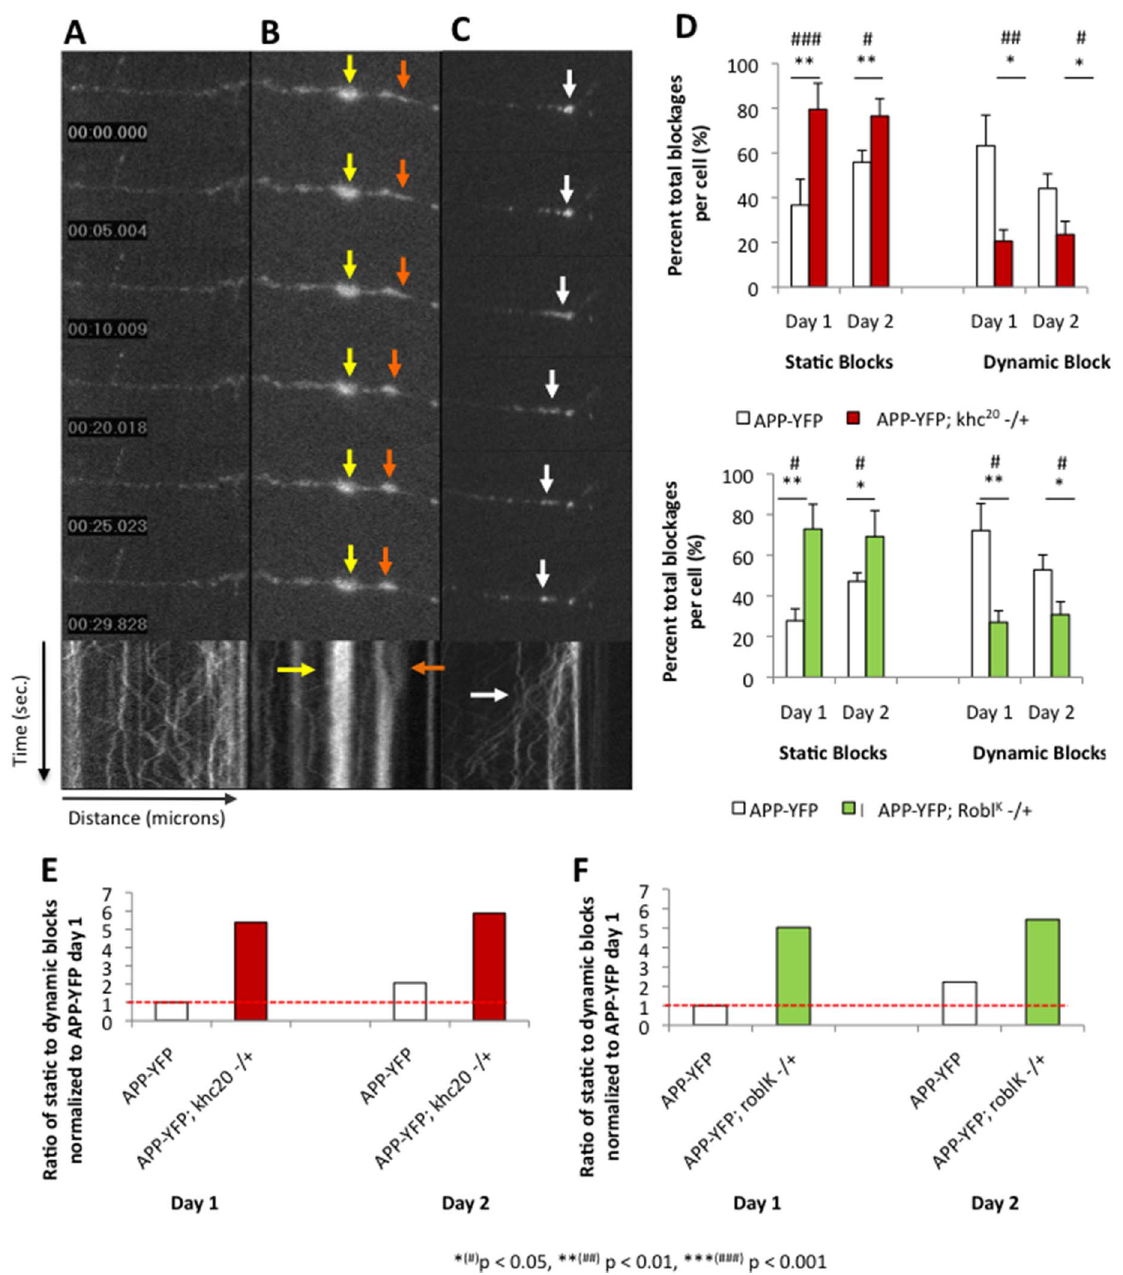
Figure 6. Two types of vesicle blockages are observed, static non-moving blocks that do not resolve over time and dynamic, clusters of vesicles that resolved over time. ( A ) In control neurites robust APP-YFP motility is observed with no vesicle blockages. A representative movie montage is shown with its kymograph. X axis=time (seconds), Y axis= distance (microns). ( B ) A representative axonal neurite shows a static non-moving APP block (yellow arrows) that do not resolve temporally (arrow in kymograph). In the same axonal neurite a static block being formed can be observed (orange arrows). ( C ) A representative axonal neurite shows a dynamic block that resolves over time (white arrow). Note that in the kymograph the block can be observed resolving over time and single vesicle tracks are seen over time (white arrow). Bar=10 microns ( D ) Quantitative analysis of the percent total blockages per cell is depicted from day 1 to day 2 for static and dynamic blocks. Note that 50% reduction of kinesin-1 or dynein significantly increases the percent of static, non-moving blocks (kinesin-1 p day1 =0.015; dynein p day1 =0.010 and p day2 =0.022), while the number of dynamic, motile blocks decreases (kinesin-1 p day1 =0.005 p day2 =0.033; dynein p day1 =0.009 and p day2 =0.022). ( E ) Normalized ratio of static to dynamic blocks shows that 50% reduction of kinesin-1 causes more static blocks compared to dynamic blocks in contrast to axonal neurites containing 100% kinesin-1 at both day 1 and day 2. ( F ) The normalized ratio of static to dynamic blocks indicate that 50% reduction of dynein also causes more static blocks compared to dynamic blocks at day 1 and day 2. Y-axis = ratio of static to dynamic blocks normalized to APP-YFP at day 1 in arbitrary units (AU), X-axis = genotype at day 1 and day 2. N=10 cells; *( # ) p , 0.05, **( ## ) p , 0.01, ***( ### ) p , 0.001 by two-tailed Student t-test (*) and by Bonferroni’s test ( # ).